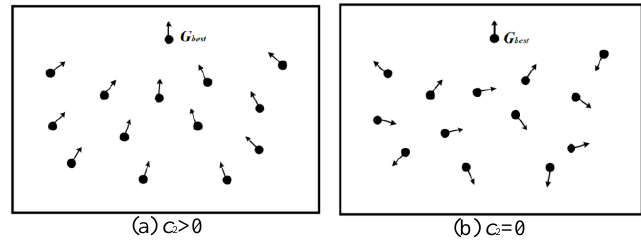
Figure 3. Convergence speed of IPSO algorithm.